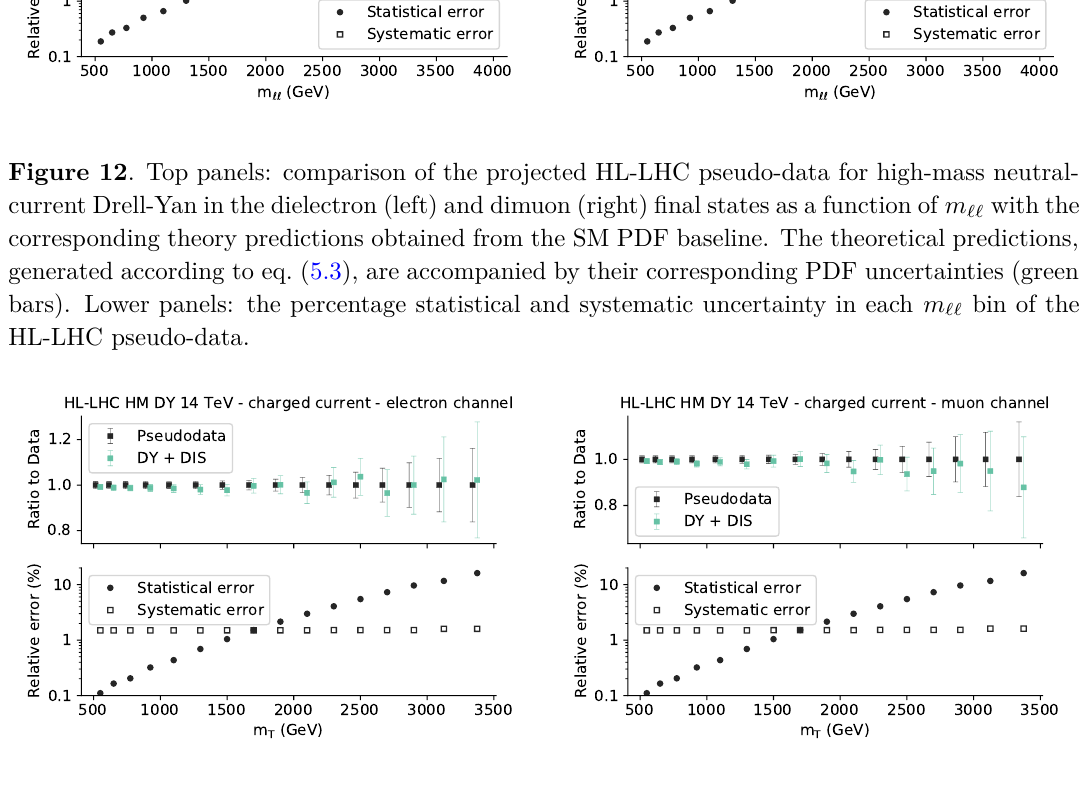
Figure 13 . Same as figure 12 for charged-current Drell-Yan in bins of the transverse mass m T . expected events will be given by f tematic errors foreseen at the HL-LHC. 2 This assumption is justified since most systematic errors improve with the sample size thanks to e.g. better